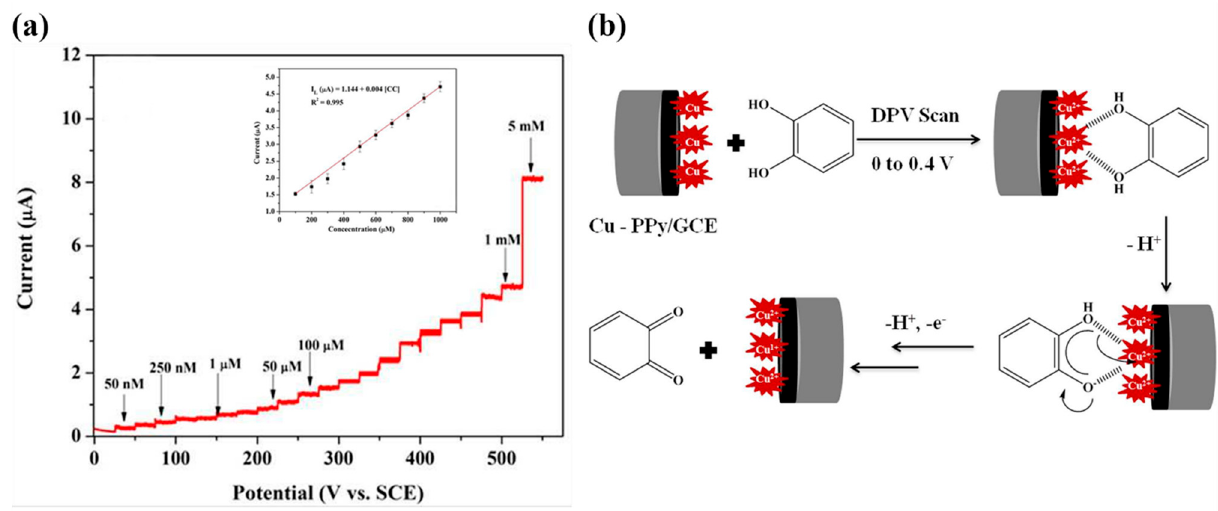
Figure 24. ( a ) Chronoamperogram for the sequential addition of catechol at Cu-PPy/GCE in 0.1 M PBS (pH = 7.0) at 0.3 V vs. SCE. ( b ) Schematic representation of the formation of a five-membered ring with Cu(II) and catechol and further oxidation of catechol at Cu-PPy/GCE. Modified with permission from [287]. Copyright 2017 Electrochemical Society.